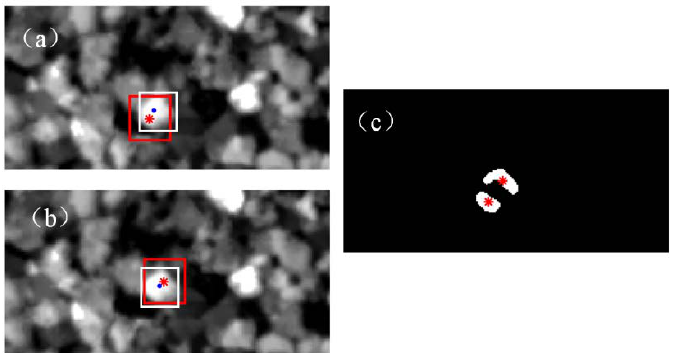
Figure 4. ( a ) Moving particle in the original position; ( b ) moving particle in current position; ( c ) binarization after two image subtraction. Red star and blue points represent particle center determined through classic subtraction procedure and the current prediction-confirmation procedure, respectively. The red square and white square is the searching area for re-recognizing the centroid and diagnostic window.